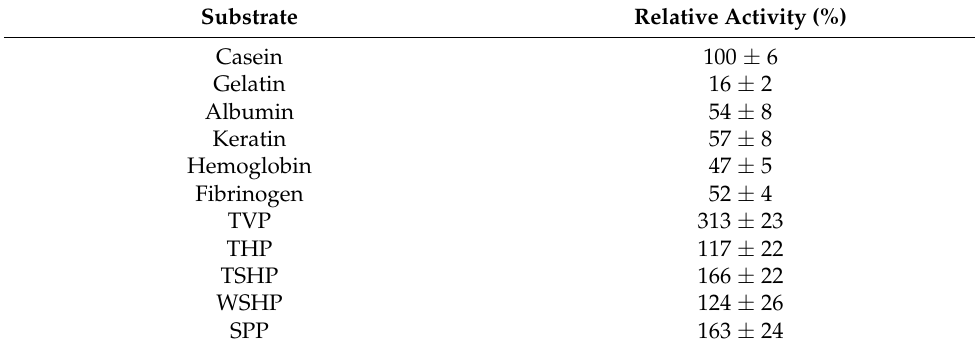
Table 6. Substrate specificity.